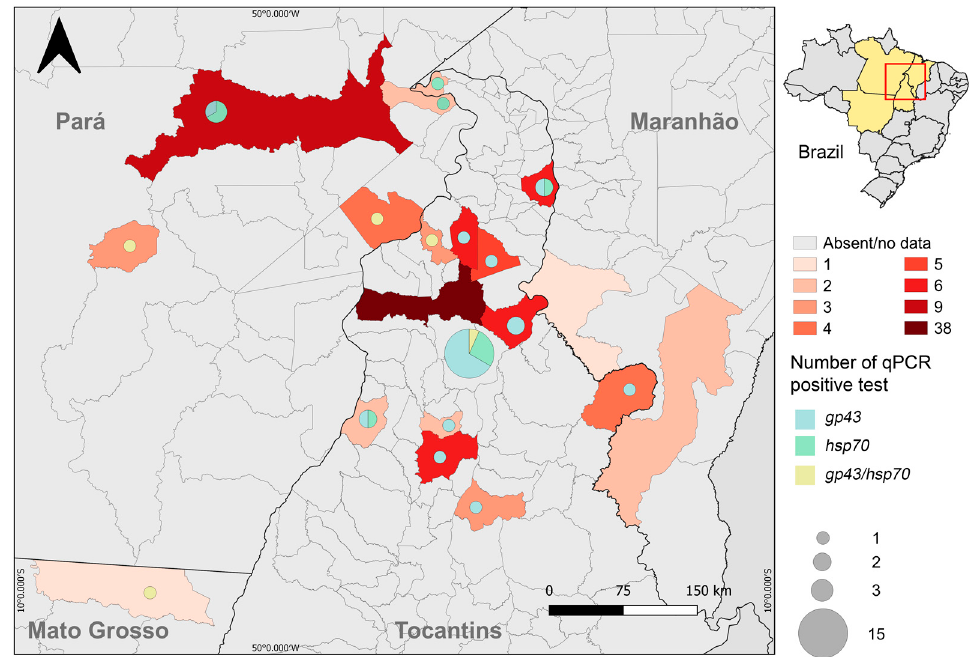
Figure 2. Spatial distribution of paracoccidioidomycosis cases in the Tocantins-Araguaia basin (red frame). Darker colors indicate a wider number of PCM cases. The PCM cases detected by qPCR were plotted next to each respective municipality in a pie chart. Paracoccidioides sp. infections detected by qPCR based on gp43 , hsp70 , or both markers are represented by different colors.